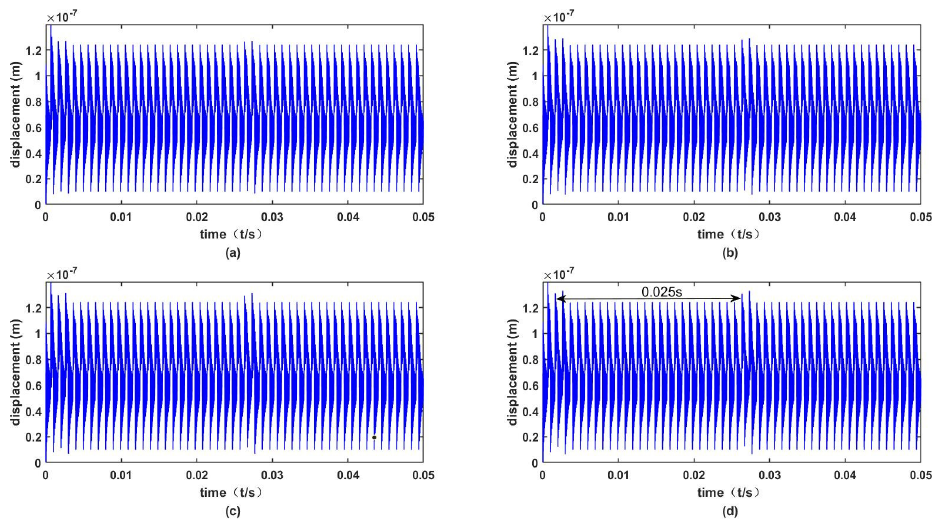
Figure 12. Vibration response with different crack angles. ( a ) Crack angle 20°. ( b ) Crack angle 30°. ( c ) Crack angle 40°. ( d ) Crack angle 50°.